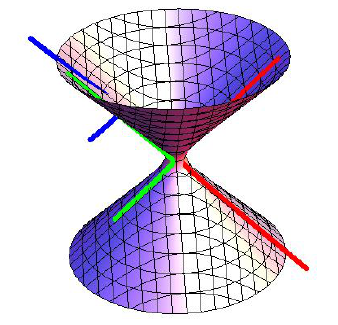
Figure 8. r (red), ˜ r (blue) and ¯ r (green) on S 2